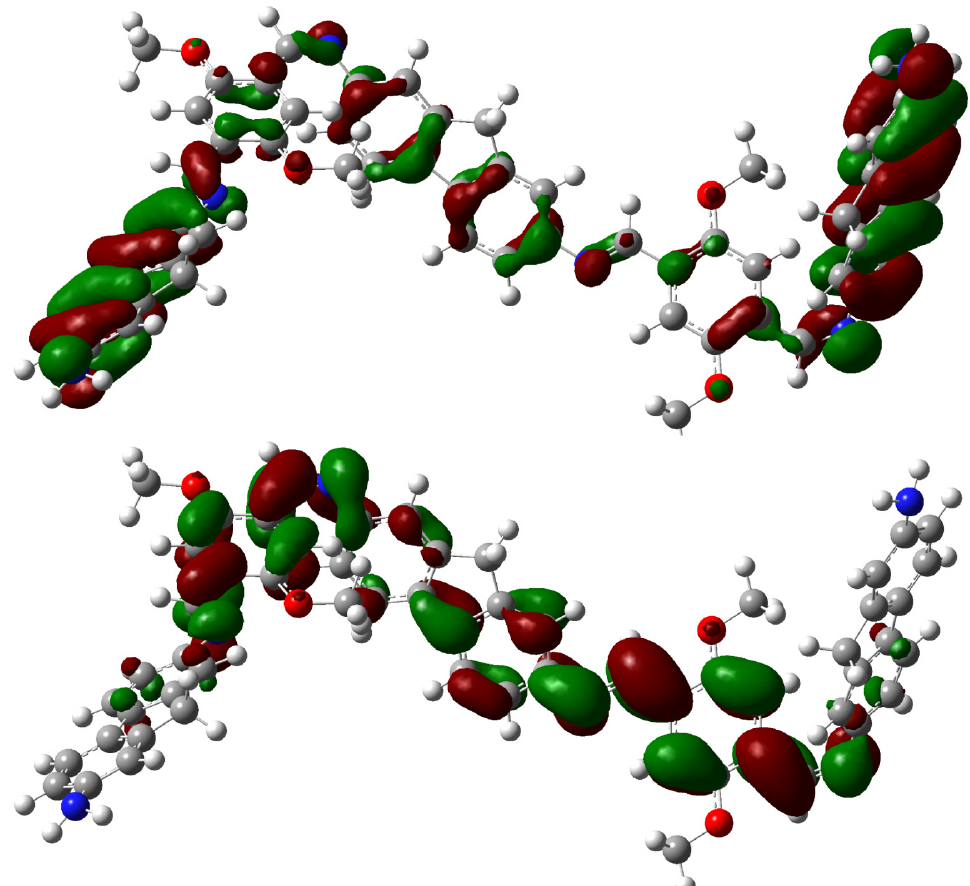
Figure 12. Molecular orbitals: HOMO (top) and LUMO (bottom) for OIC2MS calculated at the M062X/6-31G* level of theory. The aliphatic chains were removed and the geometries were optimized as described in the